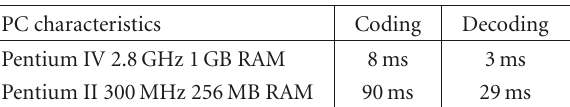
Table 5: Maximum execution times for the coding and decoding processes in di ff erent PCs.